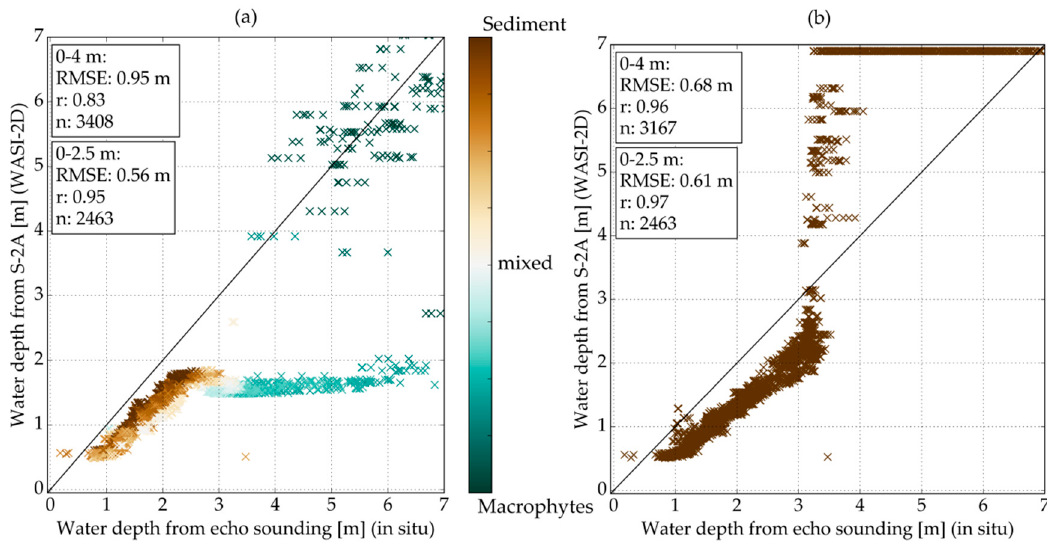
Figure 10. Scatterplots comparing echo sounding data (acquisition June 2012) and S2-A (WASI-2D) derived water depths (10 m) while unmixing two bottom types; the colour gradient highlights bottom type ( a ). Scatterplot ( b ) results from modelling water depths with fixed sediment coverage (fA[Sediment] = 1.0).